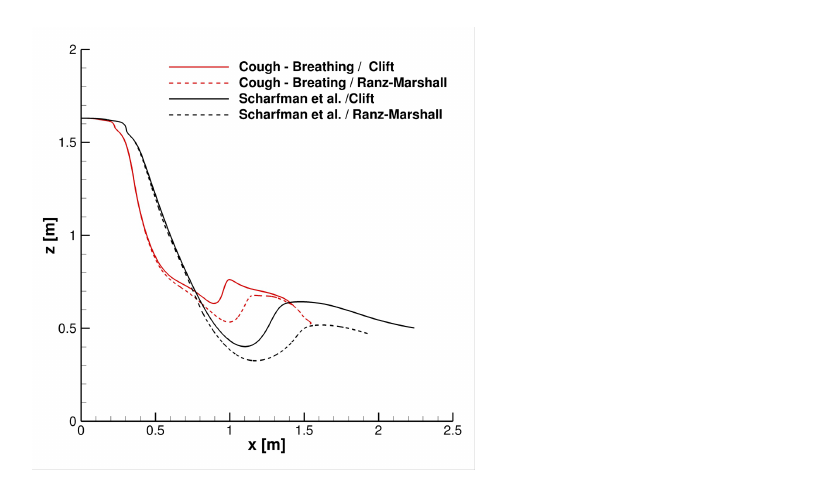
Figure 6. Saliva cloud center of mass trajectory with different BCs and Nu/Sh